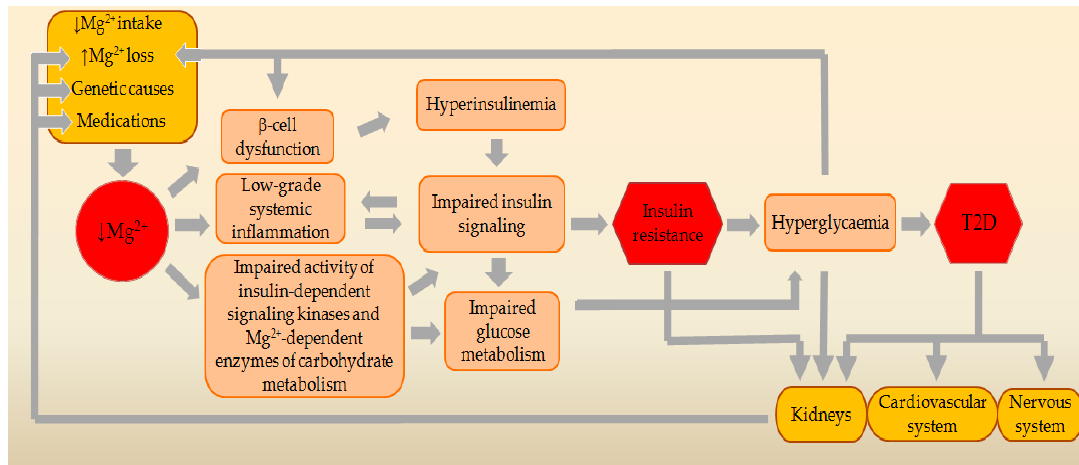
Figure 3. Schematic presentation of the pathogenetic vicious circle between MgD and IR in T2D. A number of factors can negatively affect Mg 2+ balance in the body and may result in MgD. MgD may cause beta-cell dysfunction, impaired insulin signaling, development of chronic systemic inflammation, and change in activity of key Mg 2+ -dependent signaling kinases and enzymes of carbohydrate and energy metabolism. This can ultimately contribute to development of IR and T2D. Legend: ↓ Mg 2+ , magnesium deficiency; T2D, type 2 diabetes mellitus.